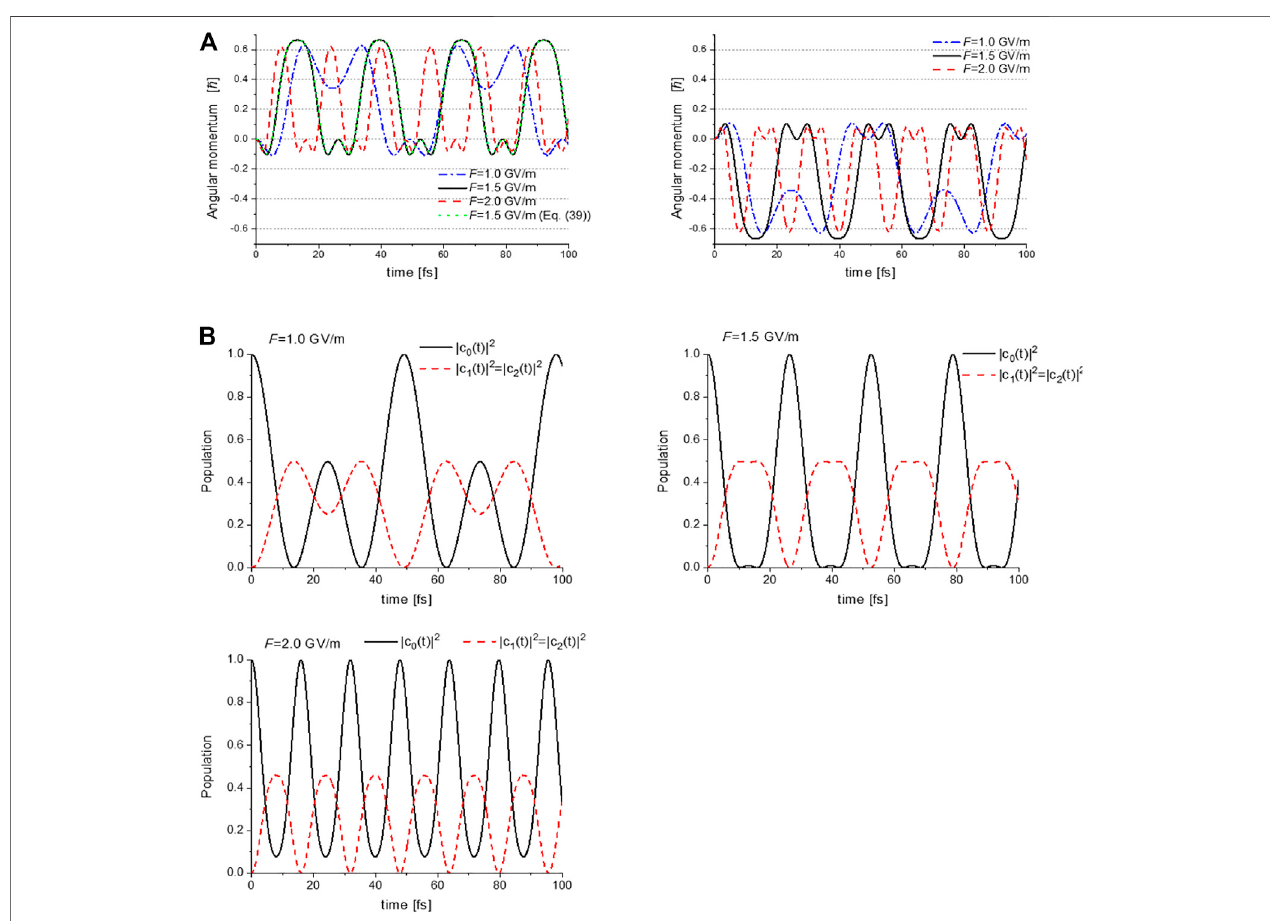
FIGURE12|(A) Expectationvaluesoftheangularmomentumoperator L Z ( t )fortoluene,calculatedwiththelaserinputparametervalues F (cid:2) 1.0,1.5and2.0 GV/m. Theleft (right) panelshows L Z ( t )withrespecttotherelativephasebetweentwolasers ζ (cid:2)− π /2( ζ (cid:2) + π /2); (B) TemporalevolutionsofthepopulationsinS 0 ,S 3 ,andS 4